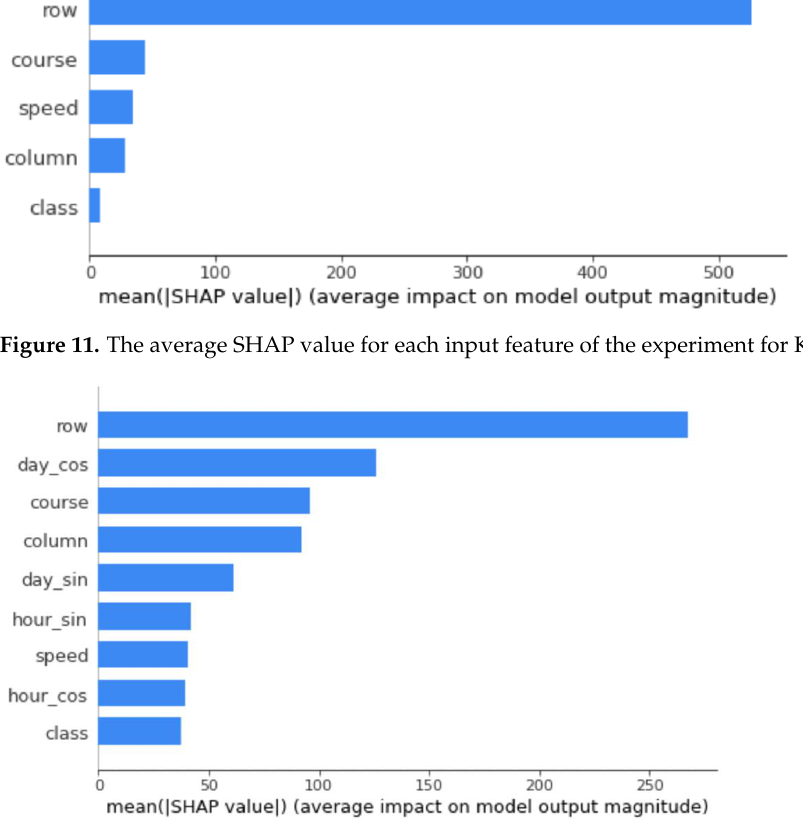
Figure 12. The average SHAP value for each input feature of the experiment for